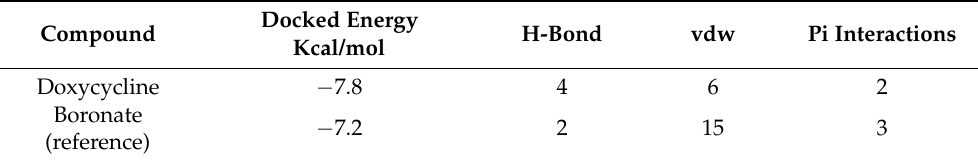
Table 1. Binding data of doxycycline and boronate to ZIKV NS2B-NS3pro.